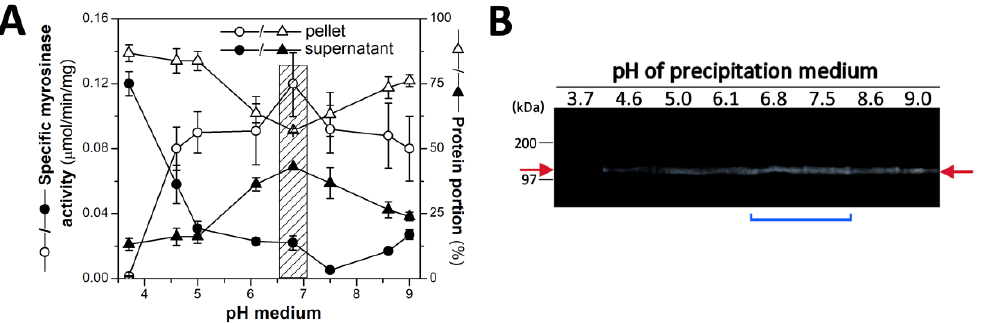
Figure 1. The effect of the pH of the medium on the efficiency of myrosinase precipitation from the crude homogenate of L. sativum seeds with 45% AS. ( A ) Distribution of specific myrosinase activities and proteins into pellets and supernatants (circle symbol represents specific enzyme activity, triangle symbols represent protein portion in pellet (empty symbol) or in supernatant (full symbol)); and ( B ) zymography analysis of the proteins (20 μg) in pellets obtained after completed precipitation at various pHs. Note: the cross-hatched box indicates the most advisable precipitation conditions with regard to the purity of the enzyme. Precipitation medium was adjusted to the required pH by adding appropriate buffer solutions (to final concentration of 150 mM): in the pH range from 4.0 to 5.0 by glycine-HCl, in the range from pH 5.0 to 7.0 by MES-NaOH, and in the range from 7.0 to 9.0 by Tris-HCl. Protein precipitation with 45% AS, measurement of myrosinase activities and zymography were performed as described in the Section 2. Red arrows indicate the band positions of myrosinase activities. The blue line segment marks the samples with the highest of enzyme activities assessed by densitometry of the zymogram bands using GelQuant 1.8.2 software (BioSystematica, Llandysul,